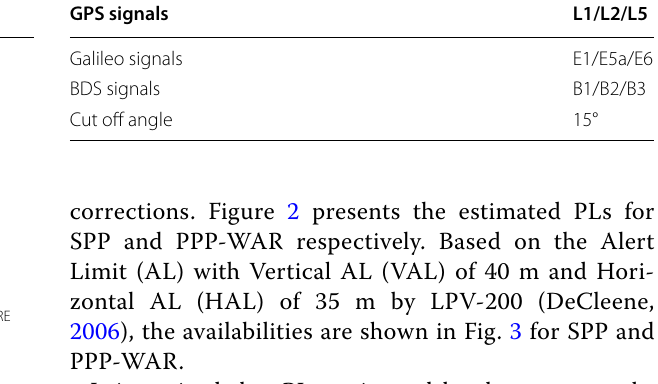
Table 3 List of processing parameters Parameters